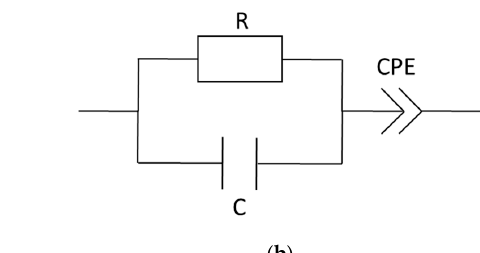
membranes, plotted as Nyquist diagram. ( a ) Whole frequency spectrum. ( b ) Zoom.